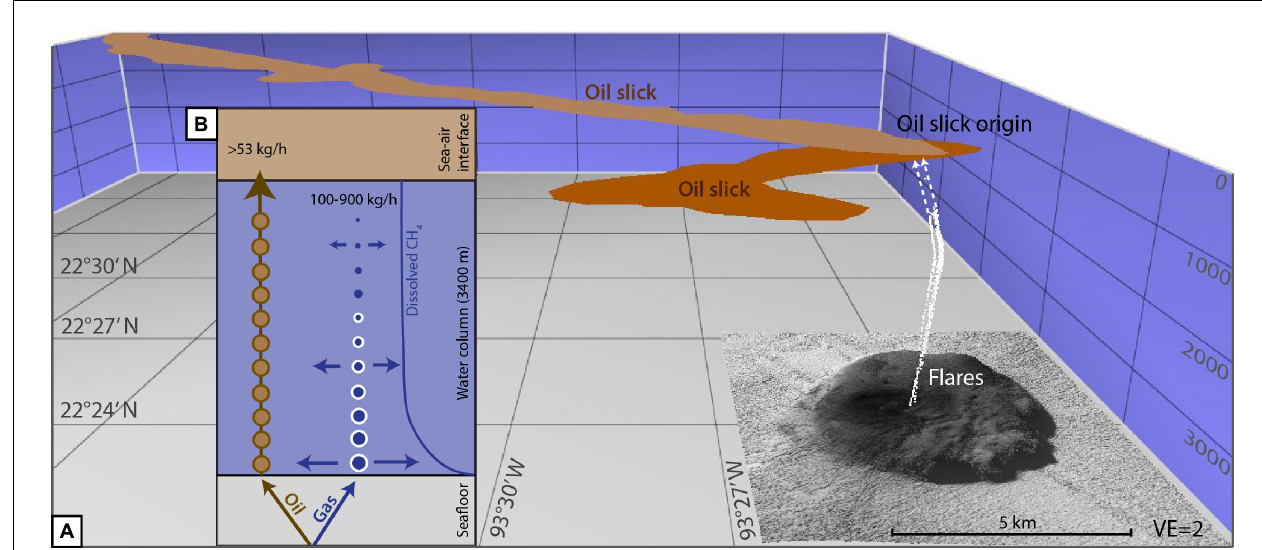
FIGURE 9 | Composite illustration of the hydrocarbon seep system investigated at Tsanyao Yang Knoll. (A) During M114, flares about 3000 m in height originated from the main seep field on top of the knoll up to the sea surface (white dots are extracted water column anomalies, white dotted line is projected path of bubbles in the upper 500 m), where oil and gas bubbles were observed. In 2011 oil emissions fueled extent oil slicks at the sea surface (Suresh, 2015). (B) Quantification revealed that only a minor fraction of the oil volume required to generate an oil slick of such an extent did originate from the oil bubble emission site that was discovered at the seafloor during an ROV dive in 2015. In contrast, gas bubbles released from the seafloor contain mainly methane that is rapidly dissolved during bubble rise through the water column. Therefore, most of the carbon released through methane bubbles remained in the lowermost water column and did not reach the sea-air